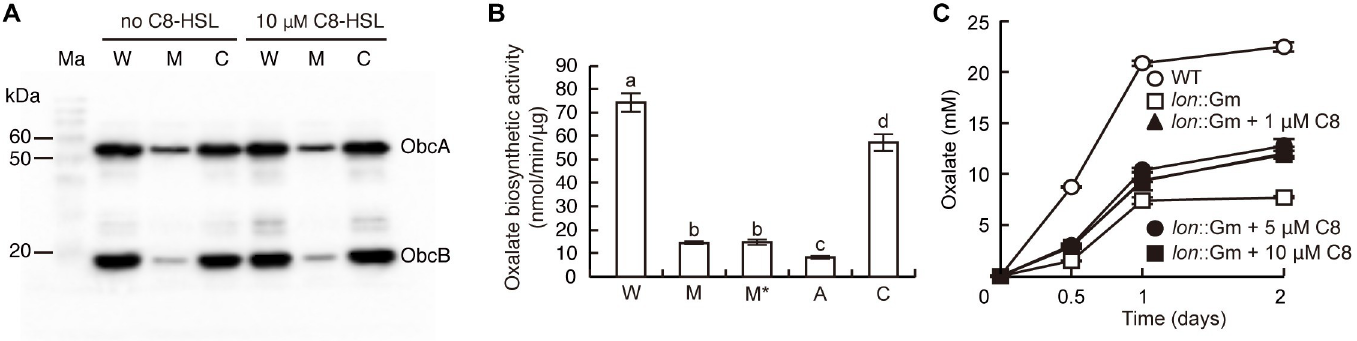
Fig 5. Supplementation of 10 μ M C8-HSL in lon mutant cultures did not increase the level of oxalate biosynthetic protein to the wild-type level. (A) The amount of ObcAB protein in the wild type, lon mutant, and complemented strains during early stationary phase was determined via western blot using anti-ObcA and anti-ObcB antibodies. Ma, W, M, and C denote molecular markers, the wild type, lon mutant, and complemented strain, respectively. (B) The specific oxalate biosynthetic activity of each strain during early stationary phase was determined. W, M, M � , A, and C denote the wild type, lon mutant, lon mutant supplemented with 10 μ M C8-HSL, obcA mutant, and complemented strain, respectively. The letters (a, b, c, and d) above each mean represent significant differences based on a one-way ANOVA followed by Tukey’s post-hoc analysis. A value of p < 0.05 indicates significant differences among strains. (C) Growth for 2 days after subculture in the LB supplemented with 100 mM HEPES (pH 7.0) and 1 ~ 10 μ M C8-HSL did not recover oxalate biosynthesis in the lon mutant to the wild type